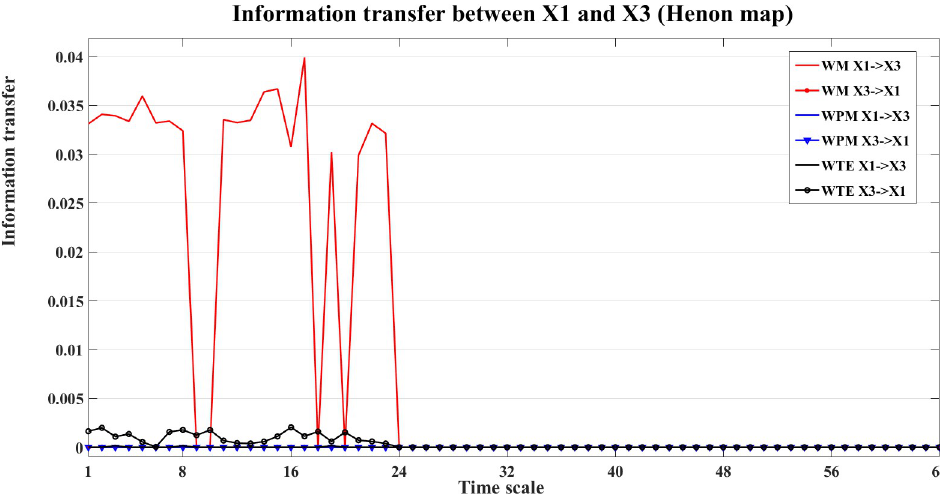
Fig 10. Information transfer between X1 and X3 for the four unidirectionally coupled Henon maps. In this figure, we present the bias corrected information transfer values between X1 and X3. The curves in different colors separately show the corrected WM (red), WPM (blue) and WTE (black) information transfer between X1 and X3, which are plotted against the different time scales.